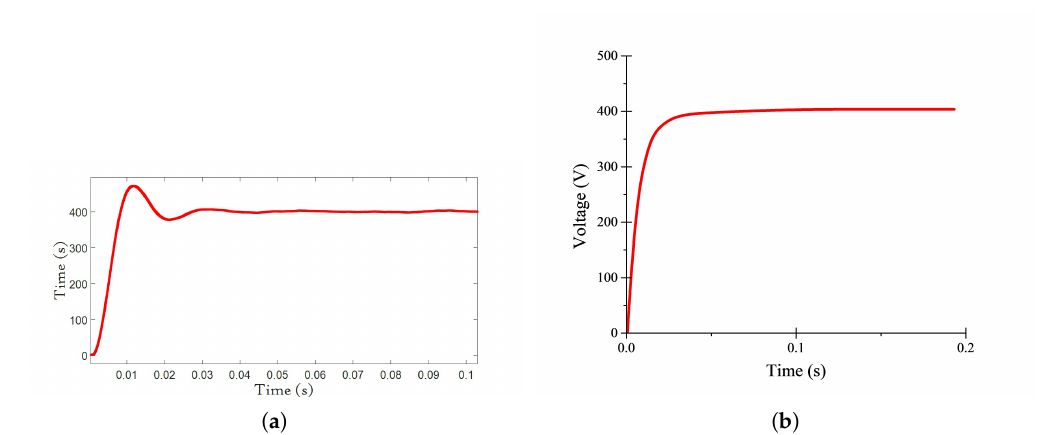
Figure 17. ( a ) Output voltage wave with conventional strategy and ( b ) output voltage with the presented control strategy.